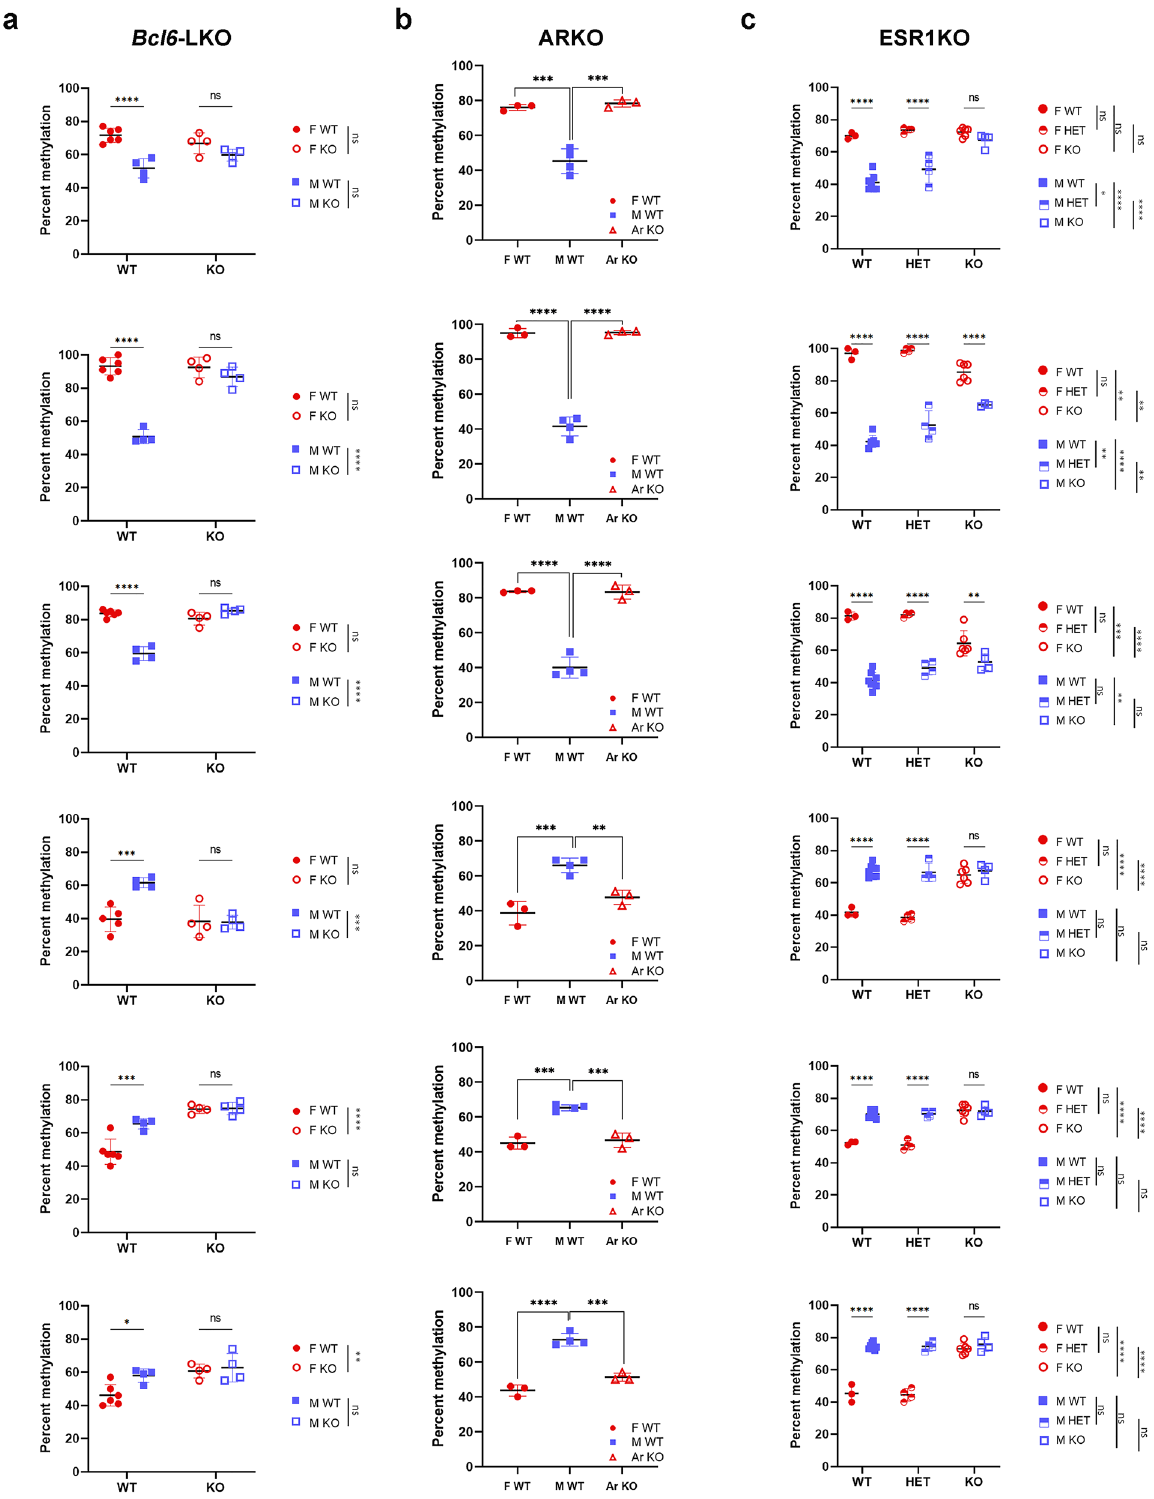
Figure 5. BCL6, AR, and ESR1 influence DNA methylation at sDMRs. ( a ) Methylation levels in male and female Bcl6 -LKO (4 females, 4 males) and controls Bcl6 -flox mice (6 females, 4 males); ( b ) Methylation levels in ARKO mice (with genetic and gonadal male sex and genital female sex) and control male and female littermates (3 females, 4 males, and 3 ARKO mice); ( c ) Methylation levels in wild type controls, heterozygous and homozygous ESR1KO mice (WT: 3 females, 7 males; HET: 4 females, 4 males, KO: 6 females, 4 males). Error bars show standard deviation. Statistically significant differences are shown with asterisks * P < 0.05, ** P < 0.01, *** P < 0.001, **** P < 0.0001, ns: non-significant [two-way ANOVA, followed by multiple testing with Sidak’s correction ( a and c ); one-way ANOVA, followed by multiple testing with Tuckey’s correction ( b